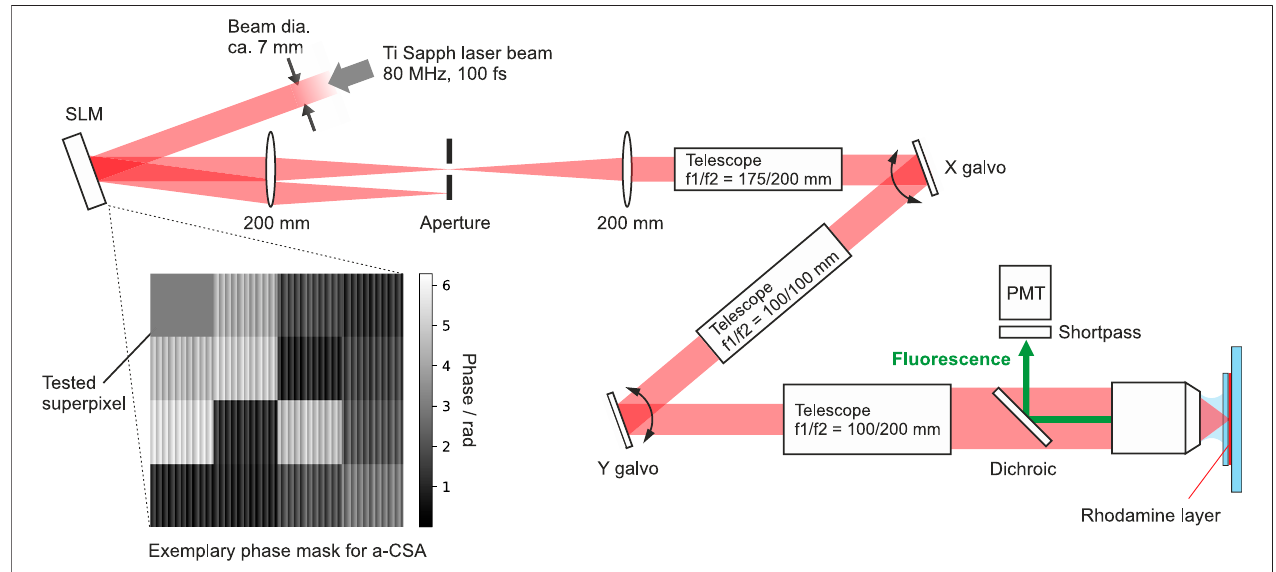
FIGURE 3 | Experimental setup. SLM = spatial light modulator; PMT = photomultiplier tube. Inset: Exemplary test phase mask for a-CSA. Every superpixel except the oneundertest issuperposed byashallow blazed gratingtodiffract thedesired fraction oflightintensityoff theopticalaxis where itisblocked byanirisaperture.This enables amplitude tunability while using a standard, phase-only